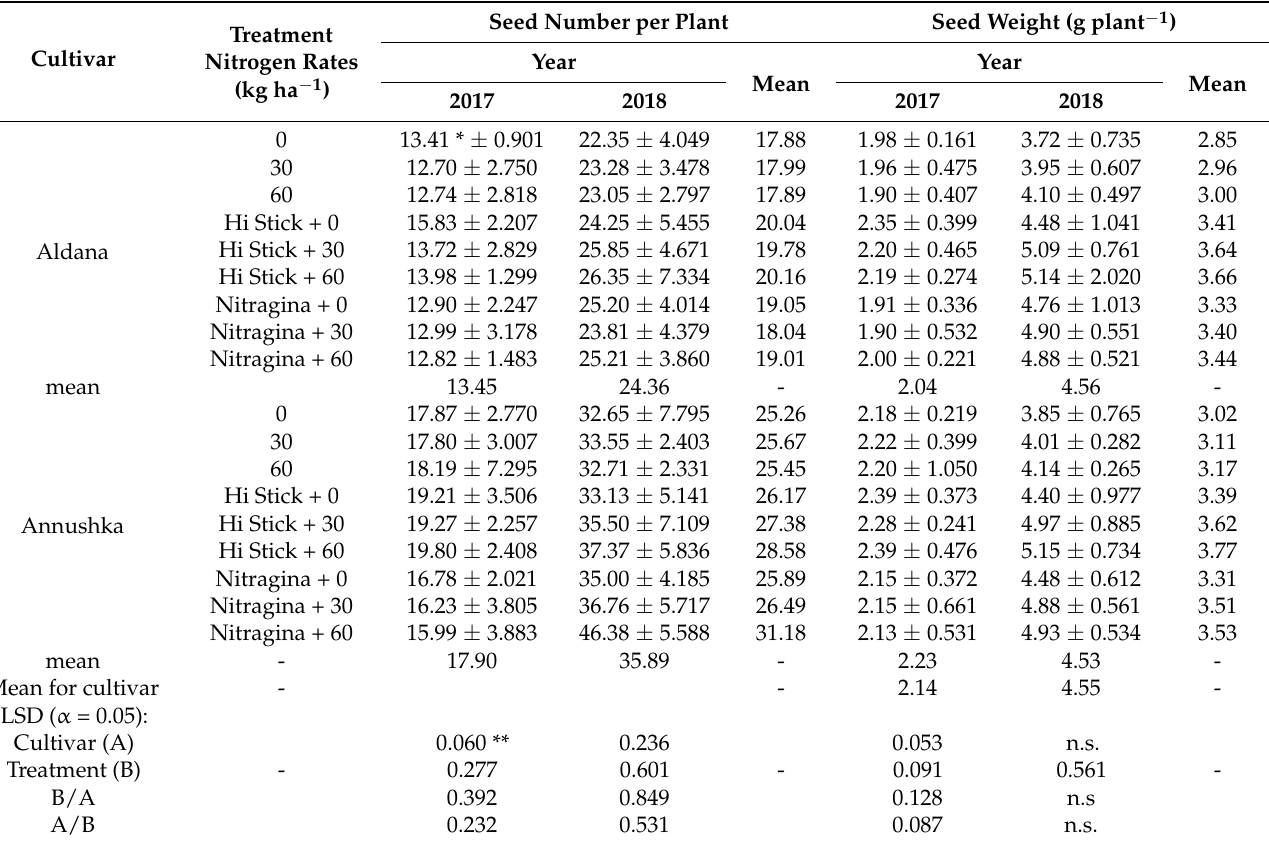
Table 4. Seed number and weight per plant depending on the mineral N fertilization applied and the